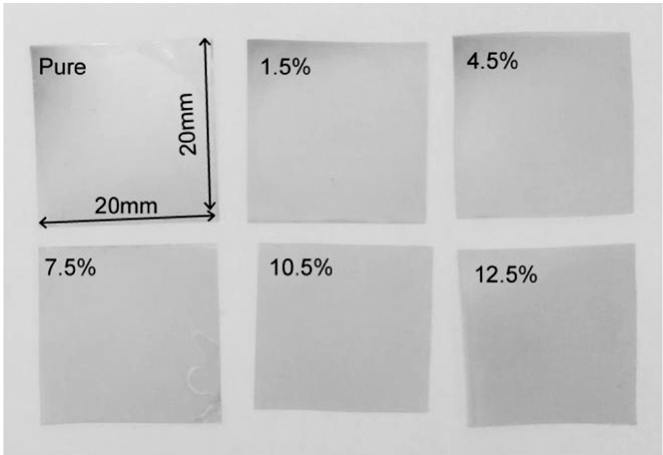
Figure 2. Six kinds of PVDF-TrFE/nano-ZnO piezoelectric films with different nano-ZnO contents were prepared.